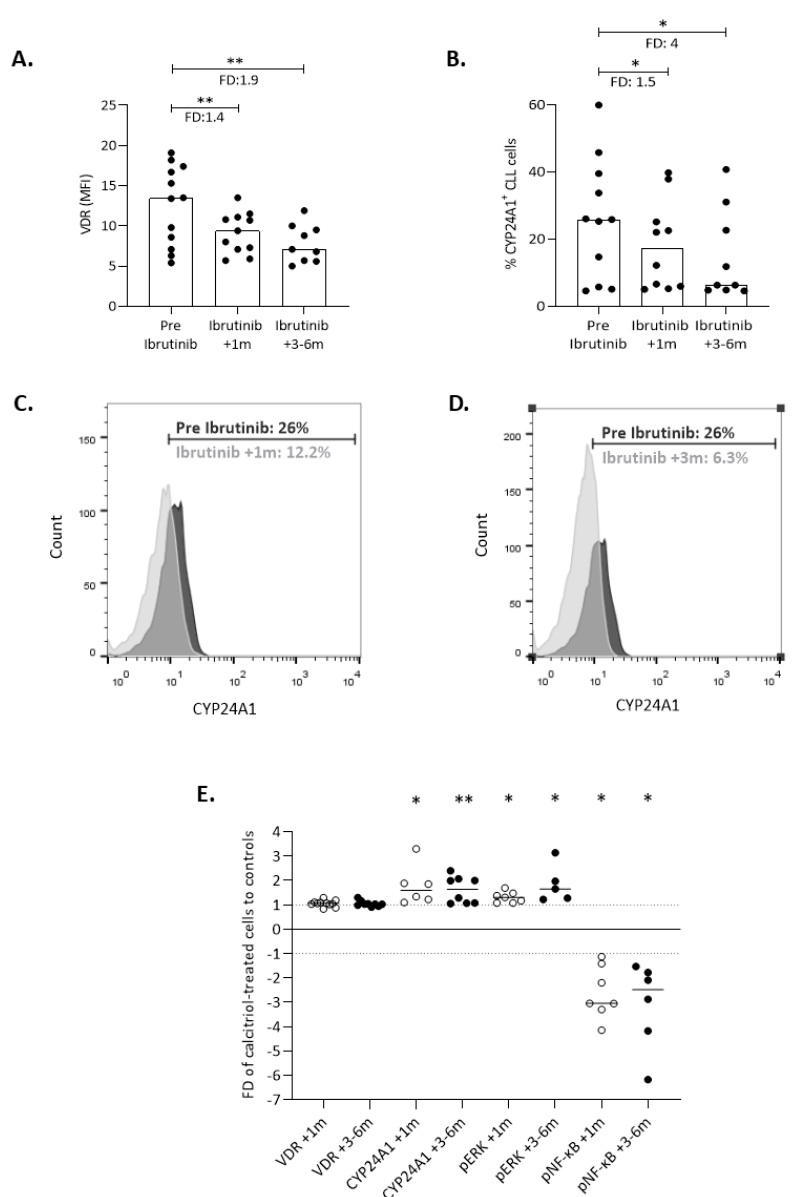
Figure 6. The calcitriol/VDR system appears unaffected by inhibition (ibrutinib) of microenvironmental signals. ( A , B ) CLL cells from patients before treatment initiation with ibrutinib and at +1m and +3–6 m under treatment were evaluated for VDR and CYP24A1 expression by flow cytometry. Bars represent the median values and the Wilcoxon test was performed to assess statistical significance. ( C , D ) Representative histograms from flow cytometry analysis for CYP24A1 + cells ( C ) at pre-treatment versus at +1 m of ibrutinib treatment and (D) at pre-treatment versus at +3–6 m of ibrutinib treatment. ( E ) VDR (MFI), CYP24A1 (% +), pERK (% +) and pNF- κ B (% +) of CLL cells treated with calcitriol. Individual data points represent the fold difference (FD) of calcitriol-treated cells to the untreated control cells and the horizontal lines show the median value. Asterisks above each time point represent statistically significant differences compared to the untreated controls. * p < 0.05, ** p < 0.01,